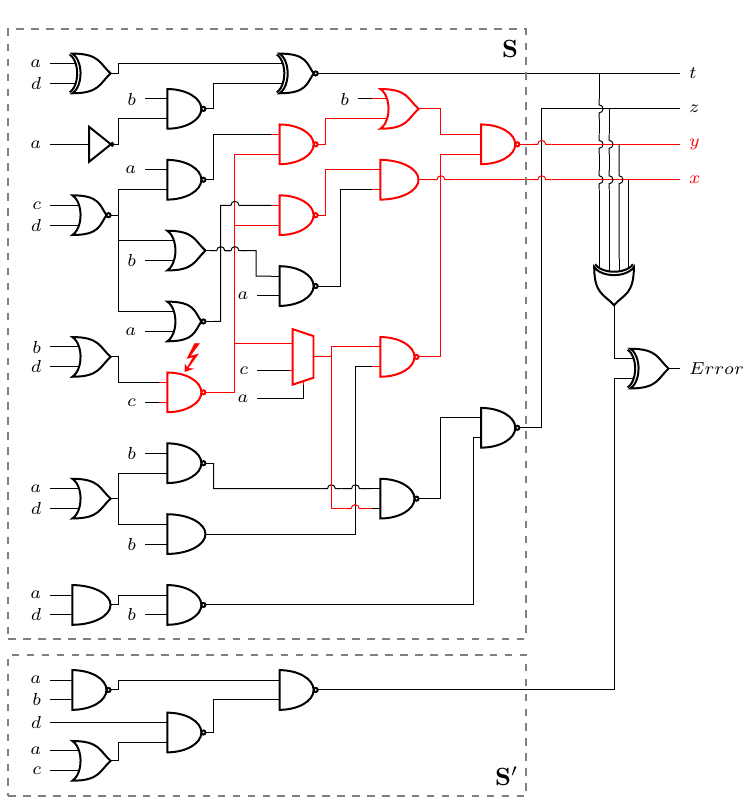
Figure 1: A simple PRESENT S-box implementation protected by a single-bit parity. The shown fault propagation happens when h a, b, c, d i ∈ { 0x1,0x2,0x3,0x9,0xA,0xB } .